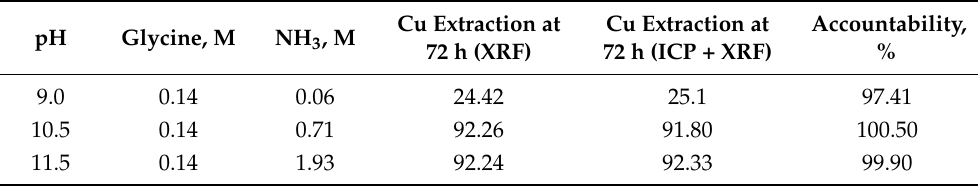
Figure 6. Cu extraction after 72 h of leaching at solution pH. Other conditions: solid/liquid ratio = 1%, Gly:Cu = 4:1, room temperature and ceramic beads: solid = 3:5. Table 6. Reagent dosages and final Cu extractions at different pH.